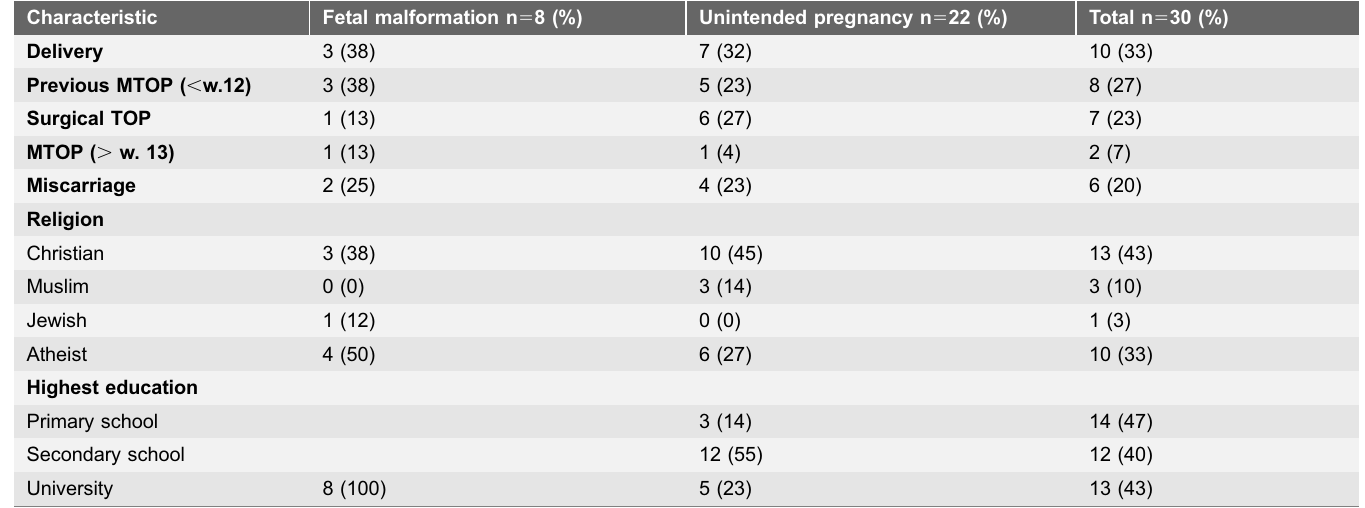
Table 3. Background factors of participants.